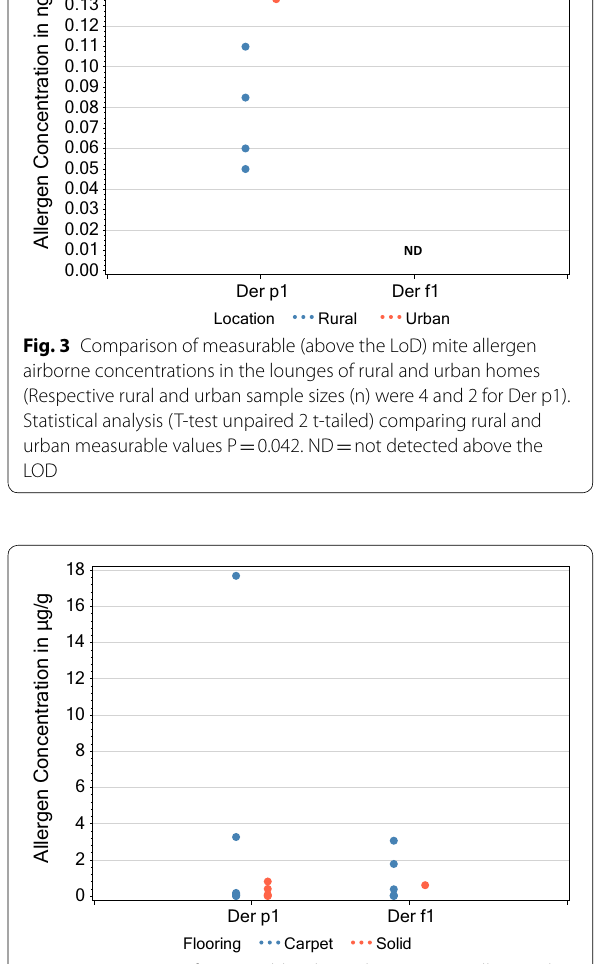
Fig. 4 Comparison of measurable (above the LoD) mite allergen dust concentrations in lounges with carpets and those with solid flooring (Respective carpet and solid flooring sample sizes (n) were 9 and 4 for Der p1 and 6 and 1 for Der f1). Statistical analysis (T-test unpaired 2 t-tailed) comparing carpet and solid flooring measurable values gave a P-values of 0.569 for Der p 1. Analysis was not possible for Der f 1 due to the single solid flooring